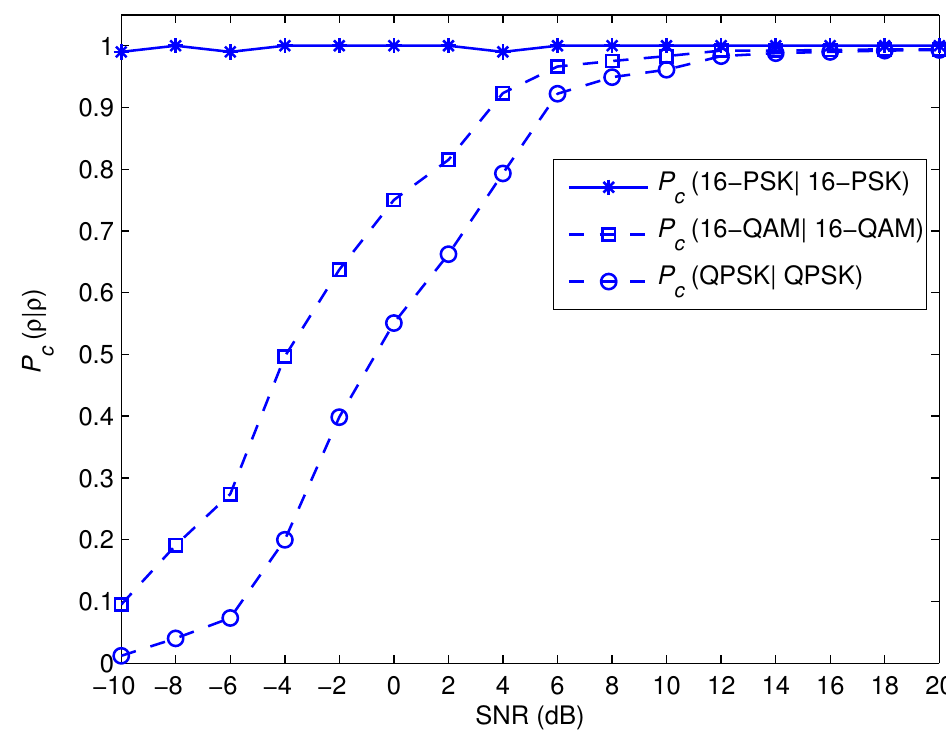
Figure 10. The categorization performance for the modulation set of Ω 3 .